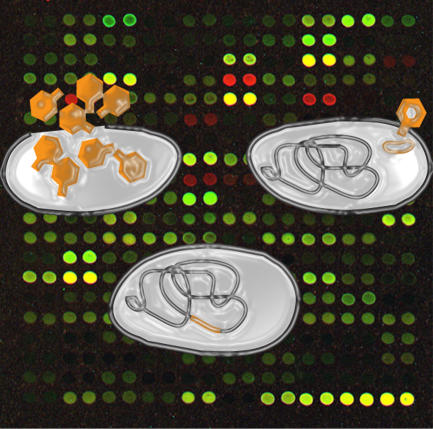
The bacterial virus λ integrates into the E. coli genome, where it shuts down the cell's ability to grow on poor carbon sources